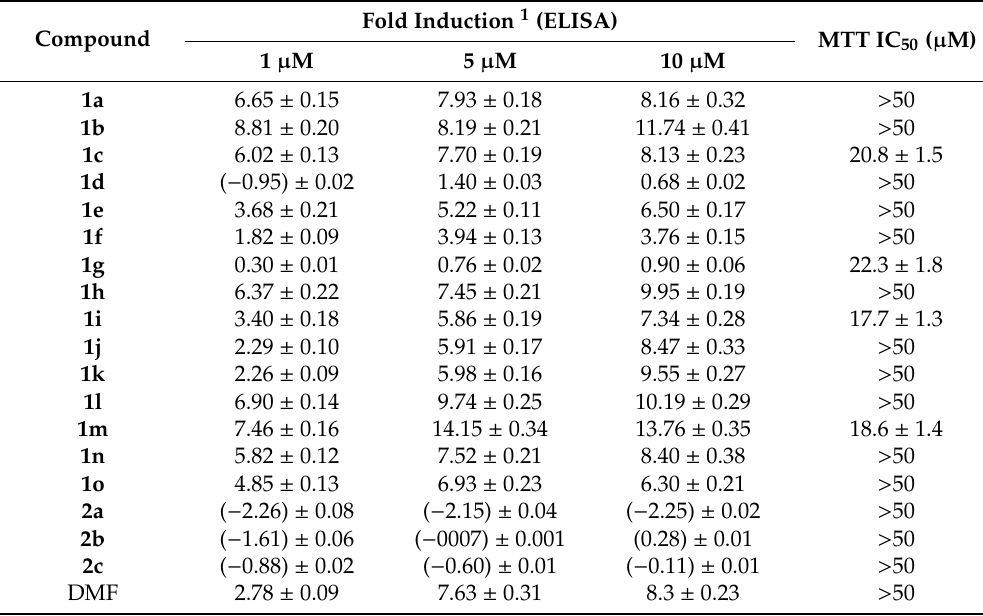
Table 1. heme oxygenase inducers (HO-1) amount determined by ELISA for compounds 1a – o and 2a – c in LX-2 cells